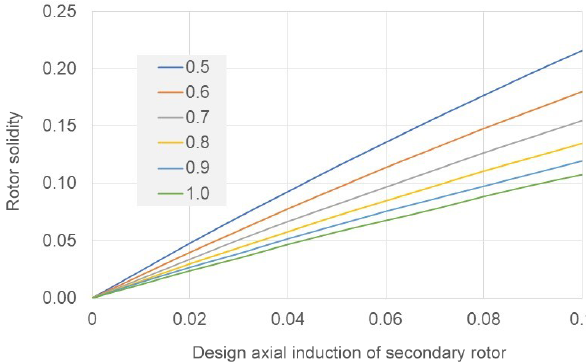
Figure 10. Rotor solidity related to design axial induction and de- sign lift